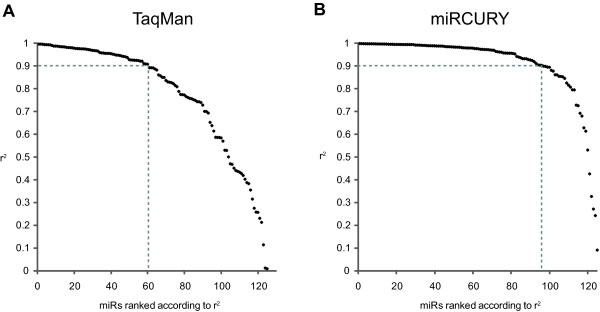
Evaluation of assay linearity at low miRNA input levels for 125 spike-in miRNAs common to the TaqMan and miRCURY platforms. Linearity was assessed based on a four point dilution series, ranging four orders of magnitude, of the spiked plasma RNA sample #1. For ease of platform comparison the data presented was restricted to the 125 spiked miRNAs queried by both platforms. The template input per PCR reaction of these 125 miRNAs ranged from 5 - 5,000 template copies (n = 62) and 20-20,000 (n = 63). Each dilution point was measured in duplicate and the linearity of each of the 125 assays was estimated by calculating the squared Pearson correlation coefficient, r2 of these measurements. Plotted are the obtained r2 values for (A) the TaqMan platform and (B) the miRCURY platform. Dashed lines correspond to number of assays with r2 ≥ 0.9.